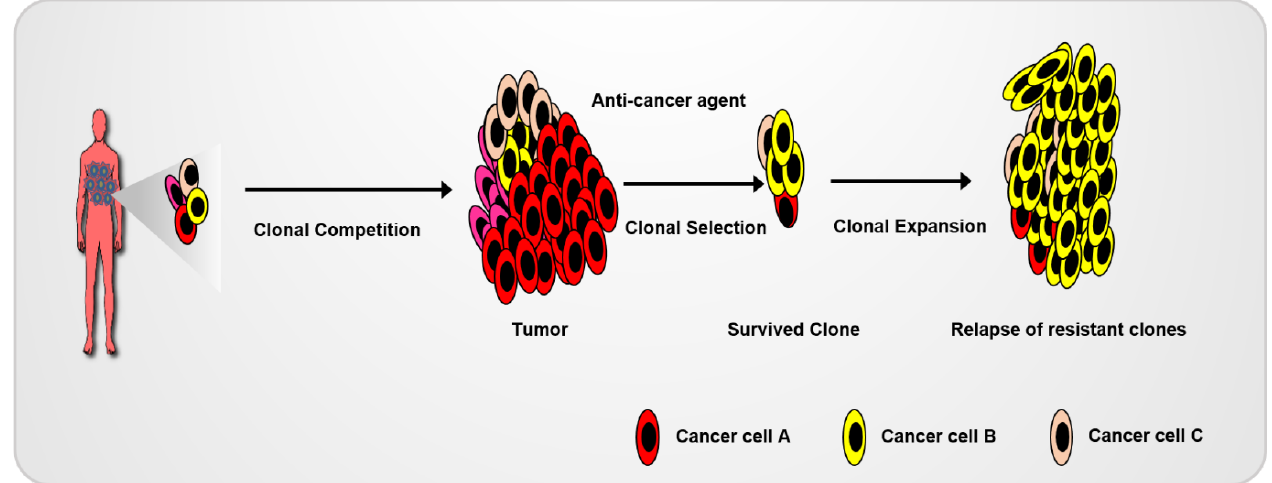
Figure 4. Diagram of recurrence in heterogeneous cancer cells.